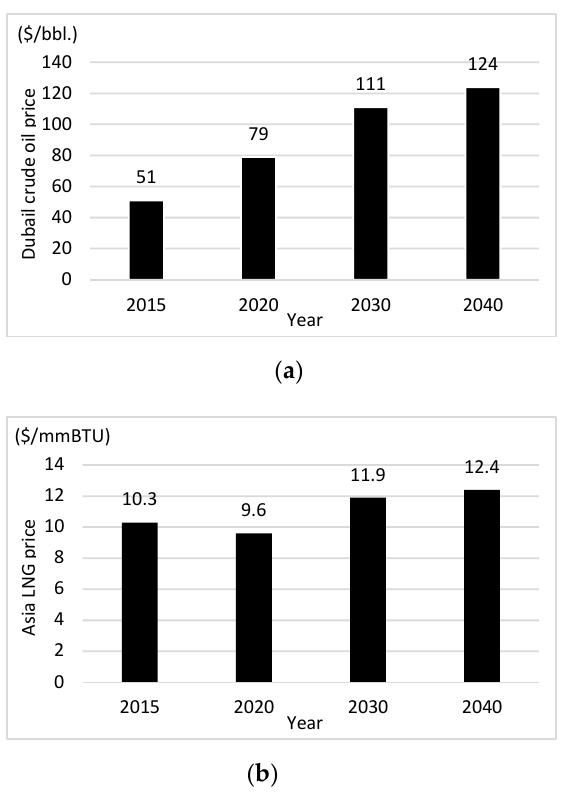
Figure 4. IEA market price projection. ( a ) Crude oil price; ( b ) Asian LNG price.